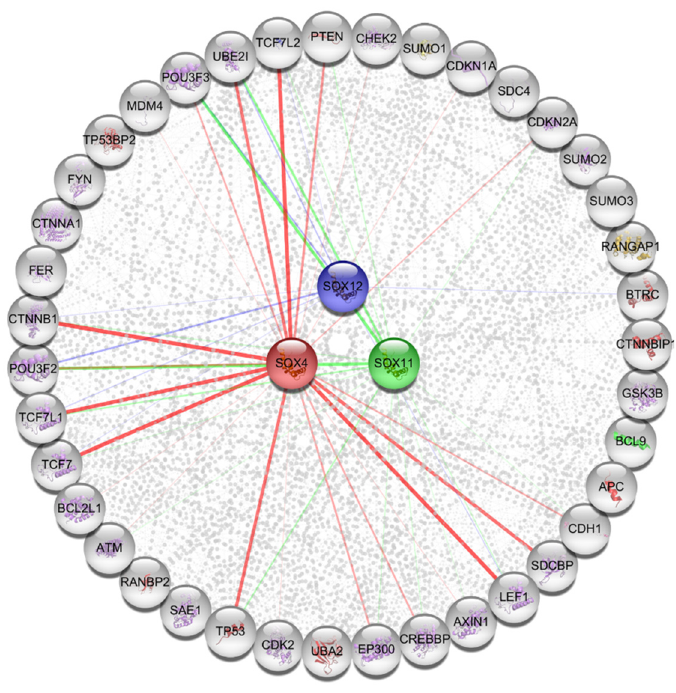
Figure 7. Functional protein partners and their predicted signaling pathways. Functional protein partners of SOX4 , SOX11 , and SOX12 were predicted using the Cy- toscape string application. The line color implies that each SOX protein interacts separately with other proteins. The node and line colors of each SOX gene were the same. SOX4 : red color; SOX11 : green color; SOX12 : navy